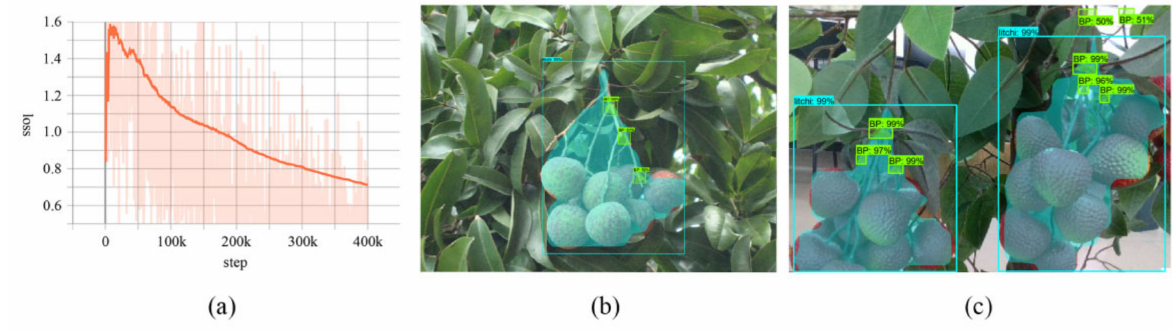
Figure 15. Results of MaskRCNN: ( a ) loss curve; ( b ) real scenarios; ( c ) model